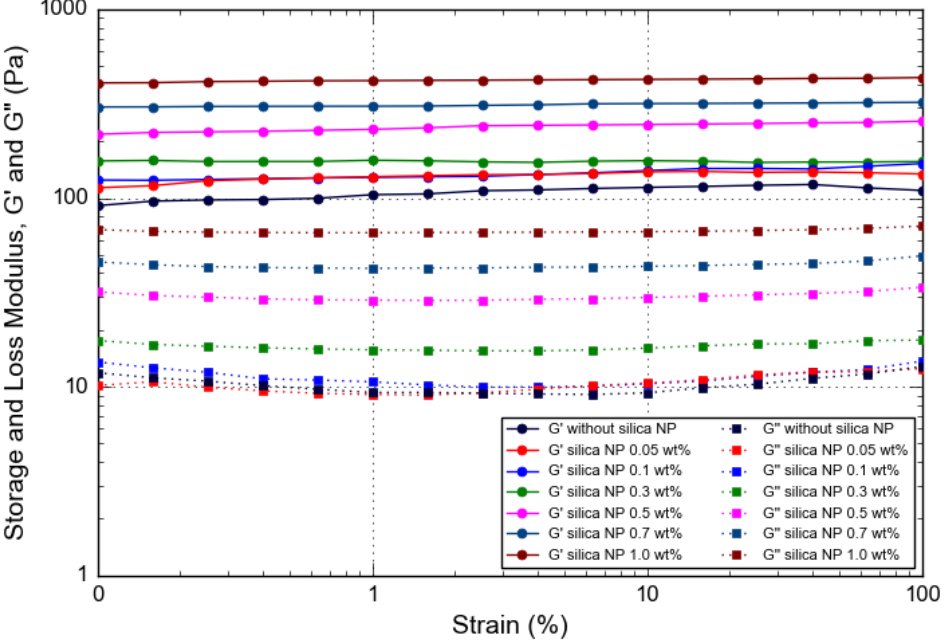
Figure 10. Storage and loss modulus, G ′ and G ″ , as a function of strain for PAM/PEI polymer gel with different concentrations of silica NP.